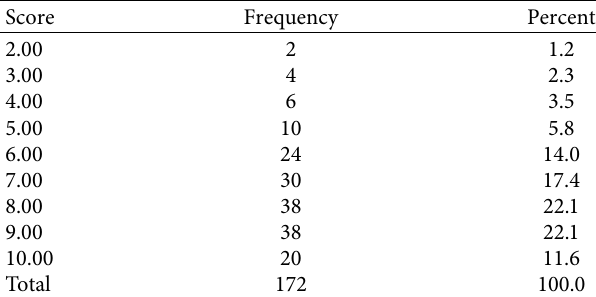
Table 2: Performance of companies in execution of fibre optic infrastructure.